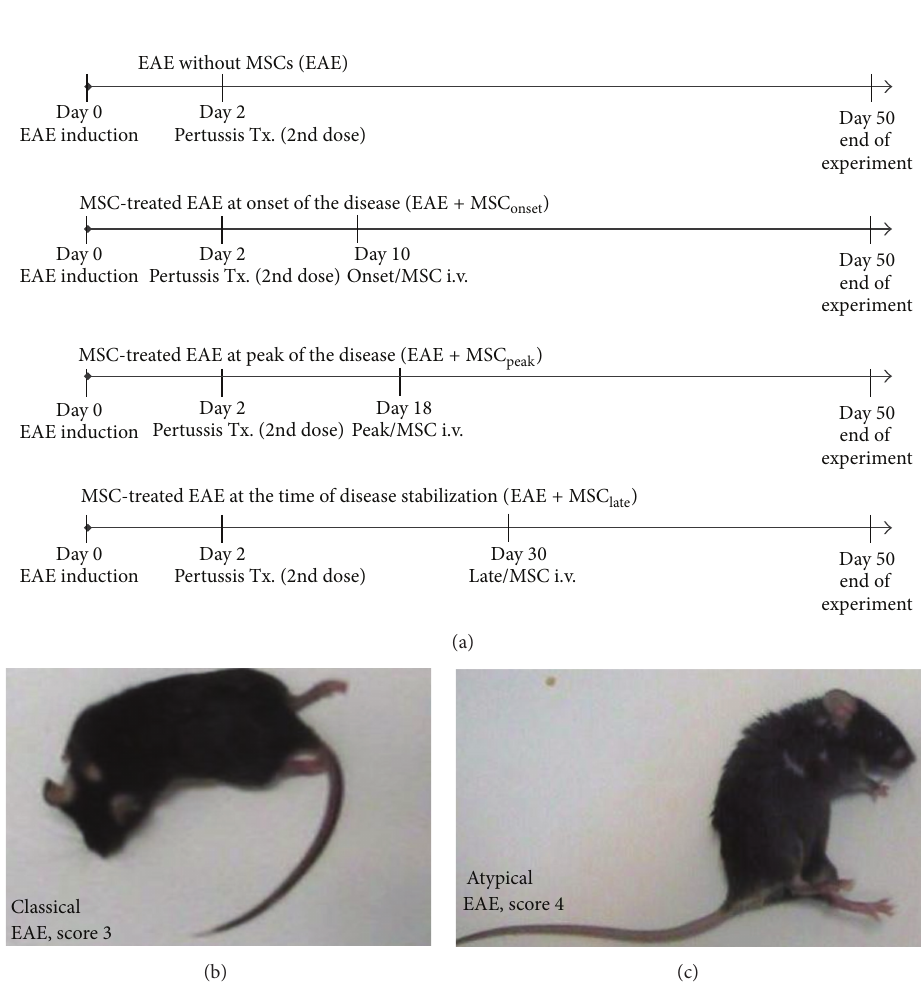
Figure 2: Experimental autoimmune encephalomyelitis model (EAE). (a) EAE induction. C57BL/6 mice were subcutaneously injected with 50 𝜇 g of MOG 35−55 , emulsified with CFA and Mycobacterium tuberculosis (4mg/mL). 2 and 48hrs later, mice were intraperitoneally injected ), at peak of the disease with Pertussis toxin (350ng/mL). MSCs (1 × 10 6 ) were intravenously administrated either at the onset (EAE + MSC onset ), or at the time of EAE stabilization (EAE + MSC ). After EAE induction, animal groups were evaluated daily for both (EAE + MSC peak late clinical score and animal weight for a total of 50 days. (b-c) Representative photographs of EAE mice manifesting the distinctive classical (b) and atypical (c) signs of the disease and their respective clinical scores are